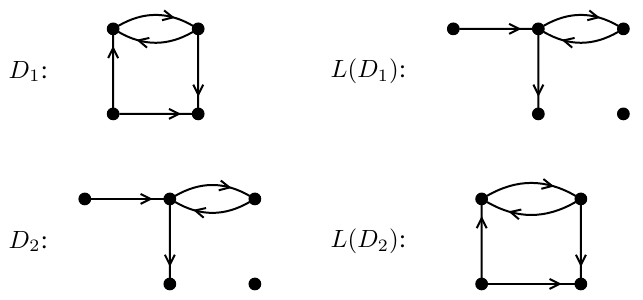
Figure 5: Two digraphs that are line digraphs of each other.